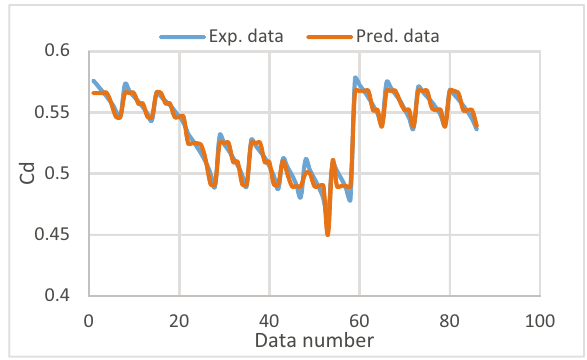
Figure 5: Comparison between experimental and predicted data in the training stage.